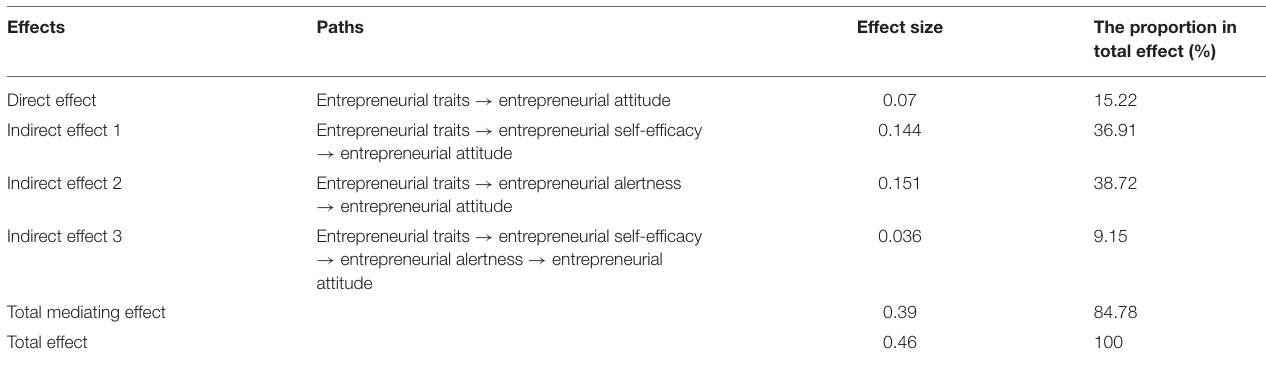
TABLE 3 | Analysis of multiple mediation effects of influencing